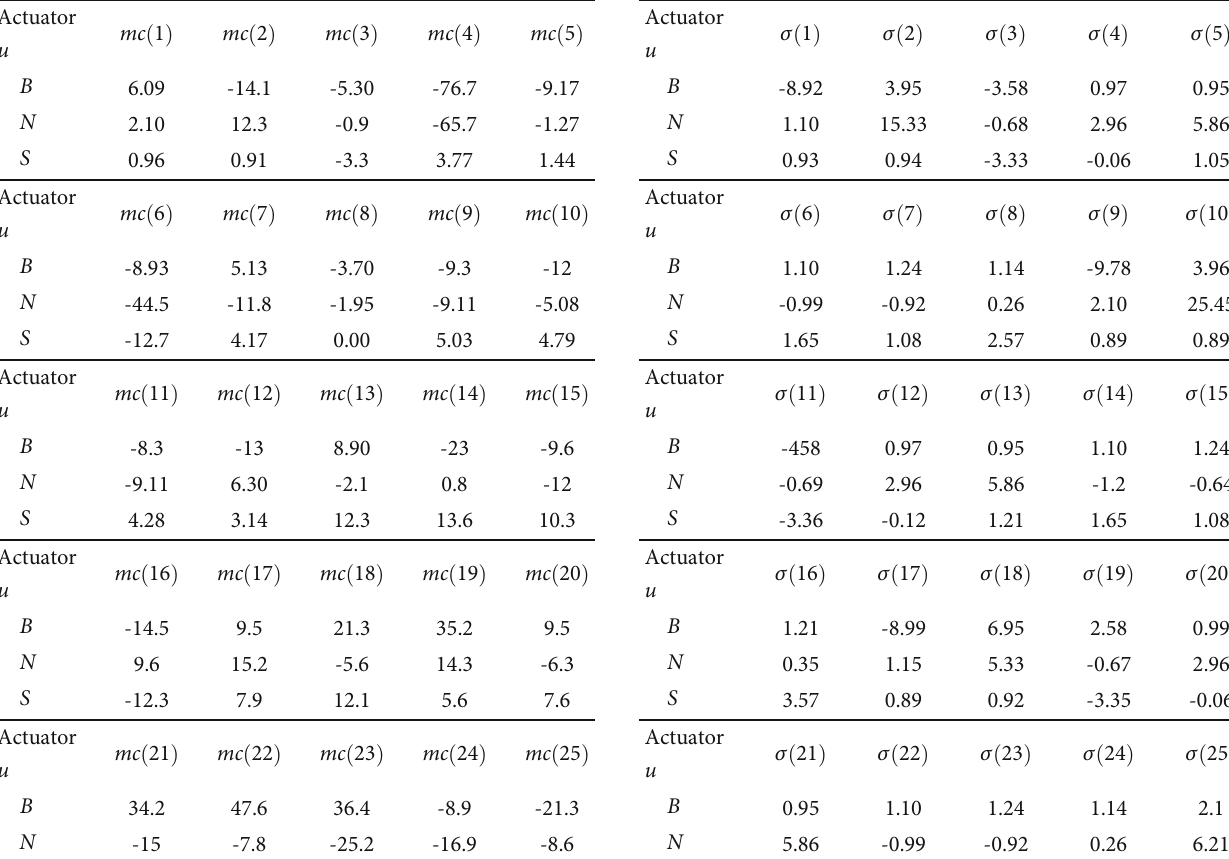
Table 11: Error change rate mc . Table 12: Clustering width σ of 25